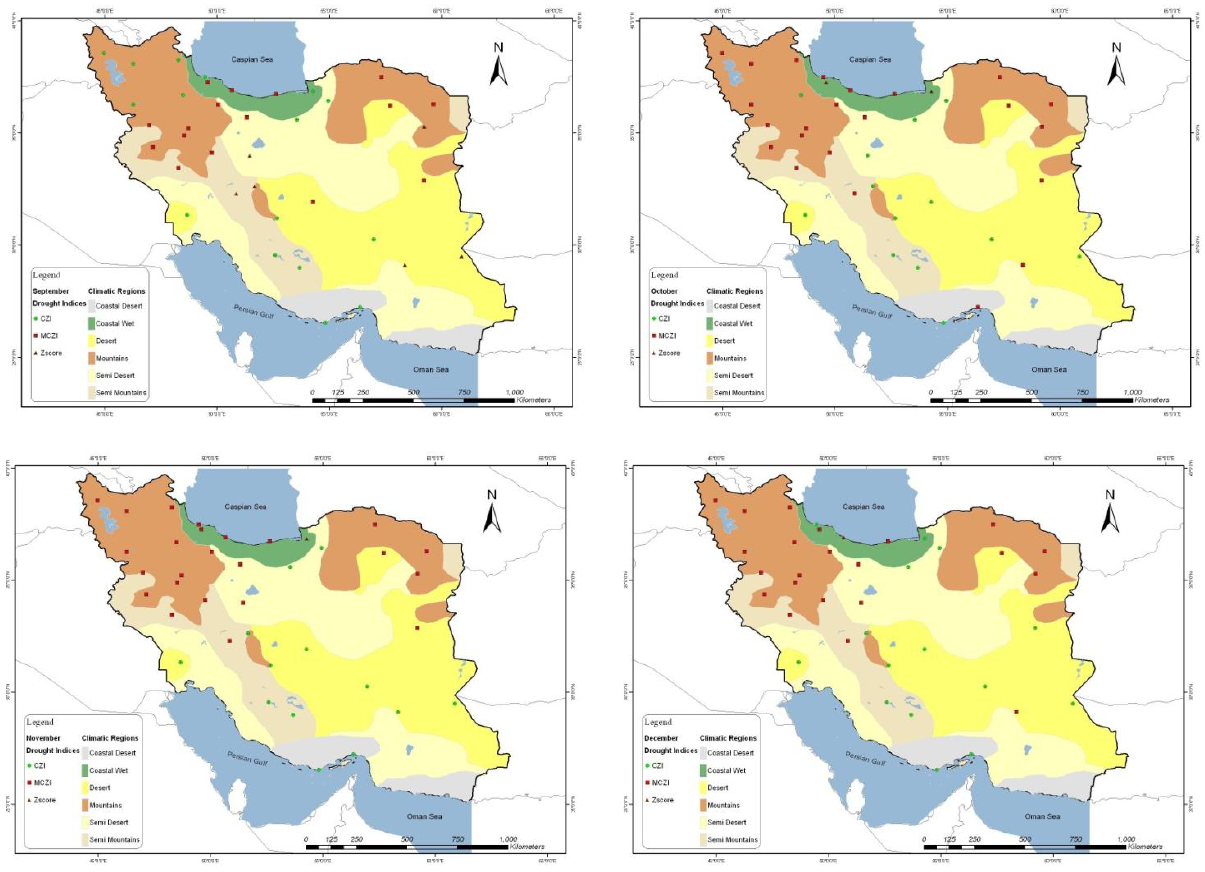
Figure 5. Spatial distribution of monthly drought indices with the best correlation to standardized precipitation index (SPI) for September, October, November and